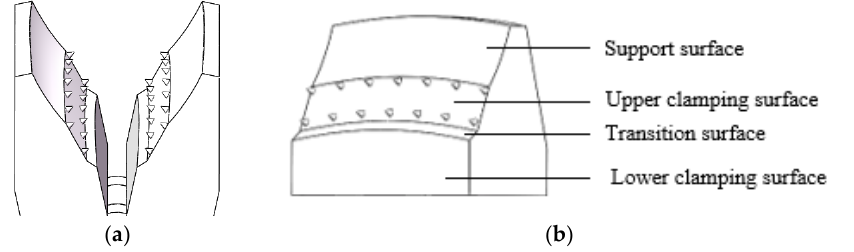
Figure 9. Adaptive clamping surface: ( a ) double clamping surface open state, and ( b ) clamping sur- face structure.